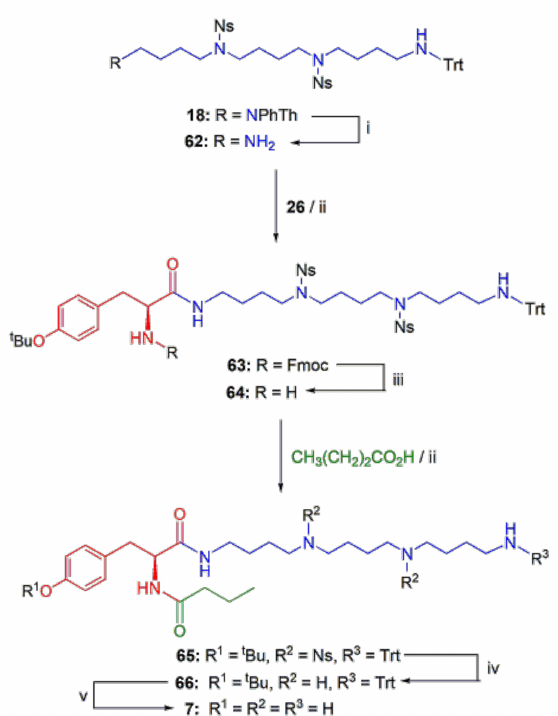
Scheme 5. Outline of synthetic route to PhTX-433 analog 7 . Reagents and conditions : (i) H 2 NNH 2. H 2